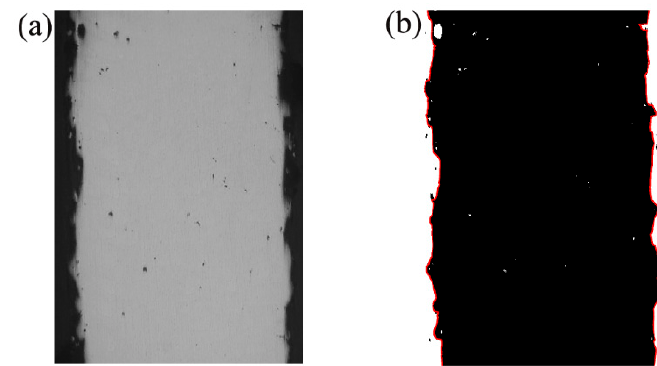
Figure 2. Original image ( a ) and Processed image ( b ).